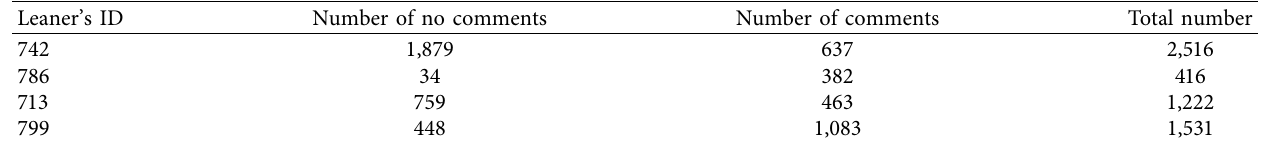
Table 3: Comments from learners with an approximate comment index of